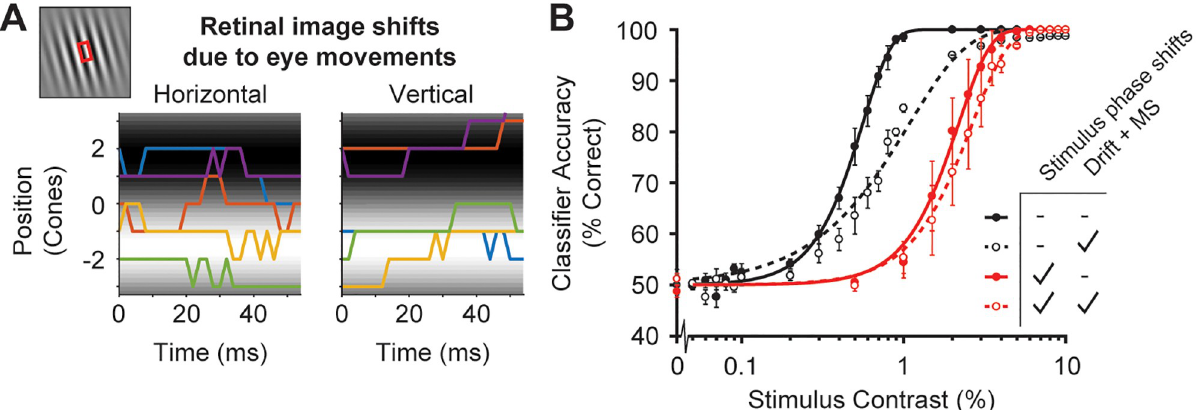
Fig 6. The effect of fixational eye movements on model performance. (A) Horizontal and vertical and 2D displacements in units of cones of the retinal image over time. Colors indicate eye movement paths of 5 example trials. A 1D slice of a single cycle of the Gabor stimulus is shown as the background (red box). (B) Computational observer performance with eye movements and stimulus phase shifts (red dashed), phase shifts only (red solid), eye movements only (black dashed) and neither (black solid). Accuracy is averaged across 5 simulated experiments which each have 400 trials per stimulus contrast. Error bars represent standard error of the mean across the 5 simulated experiments for each stimulus contrast.